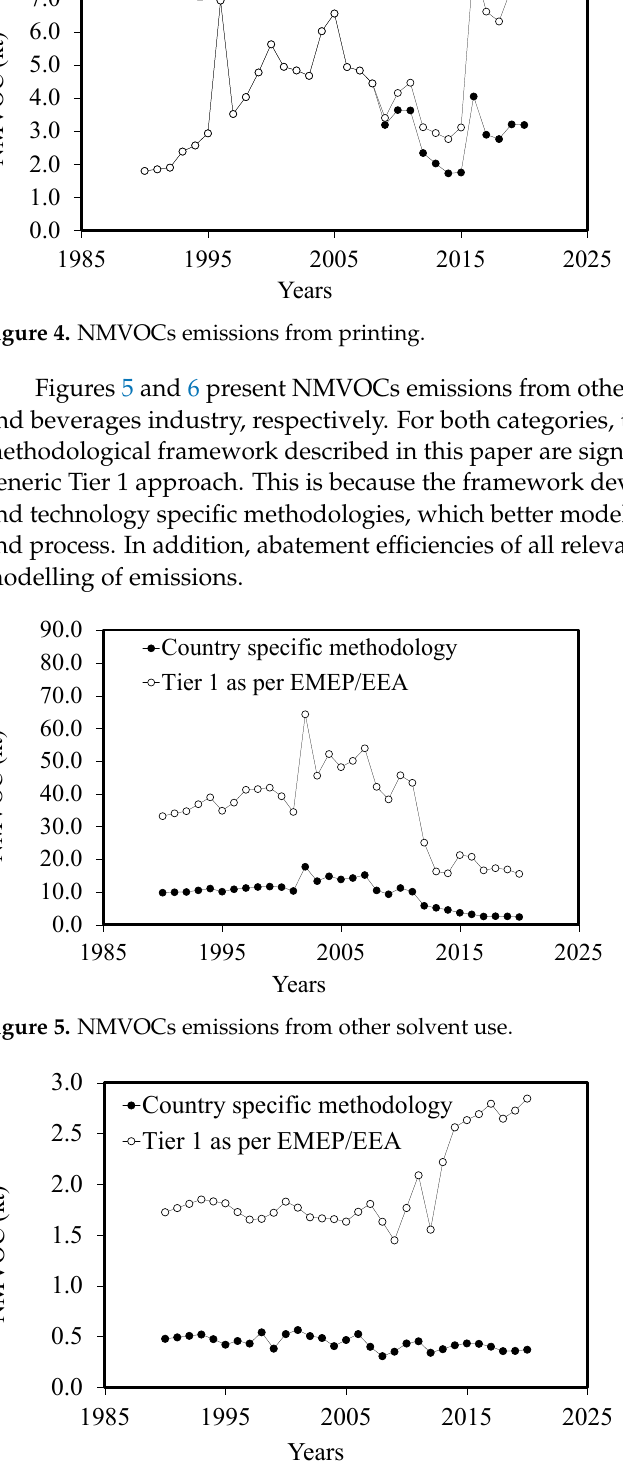
Figure 3. NMVOCs emissions from chemical products.